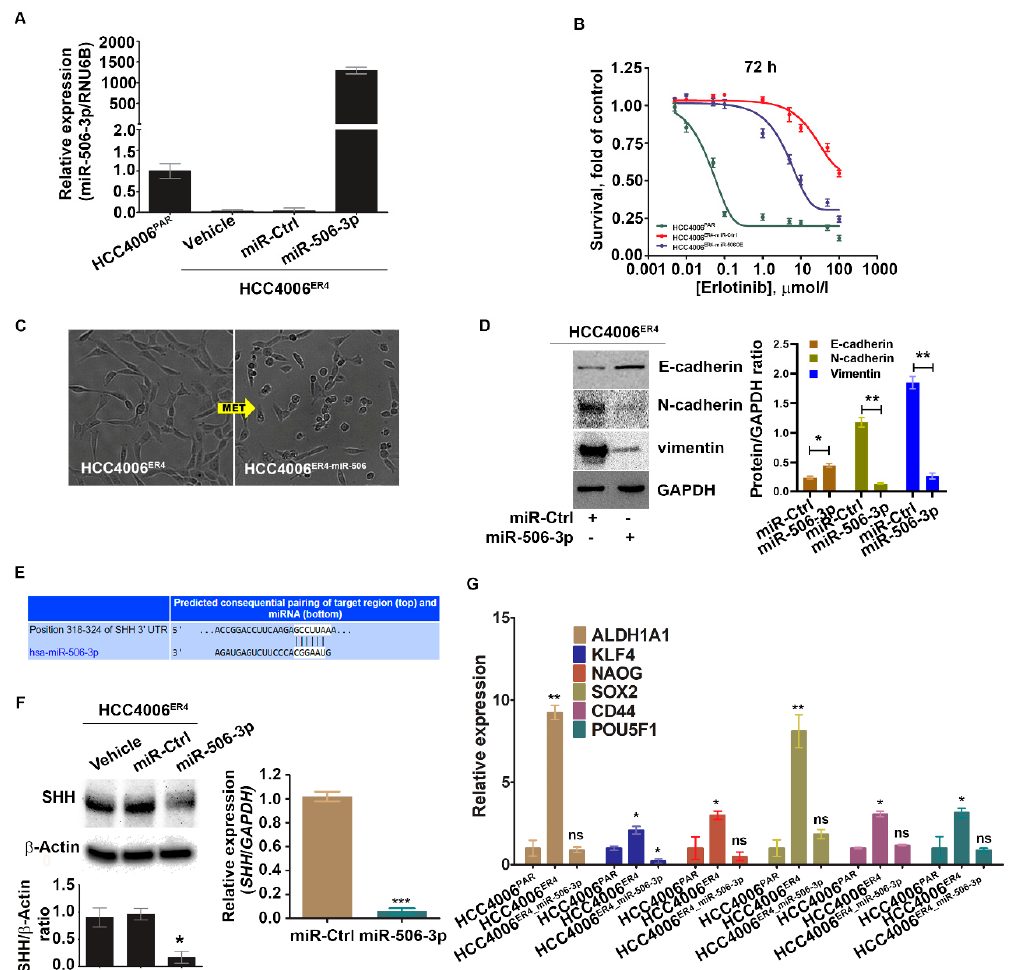
Figure 4. Ectopic expression of miR-506-3p increases erlotinib sensitivity by reversing EMT and downregulating SHH and other stem cell markers. ( A ) Real-time PCR analysis of miR-506-3p after transfection with miR-506-3p vectors into HCC4006 ER4 cells. The expression of miR-506-3p was normalized to the expression in HCC4006 PAR cells. Data are expressed as the mean ± SD, * p < 0.005, ** p < 0.0002 when compared to HCC4006 PAR . ( B ) The survival curves of HCC4006 PAR , miR-control erlotinib-resistant cells (HCC4006 ER4-miR-Ctrl ), and miR-506-3p overexpressed resistant cells (HCC4006 miR-506-3pOE )inthepresenceofdi ff erentconcentrationsoferlotinib. ( C )Thephotomicrographs represent the morphological changes (from mesenchymal-epithelial transition, MET) in HCC4006 ER4 and HCC4006 miR-506-3pOE cells (Magnification, 10 × ). ( D ) Western blot analyses of EMT markers in HCC4006 ER4 cells transfected with miR-Ctrl and miR-506-3p vectors. The right panel shows the SDi-quantitative estimation by densitometry analysis of protein bands. For semi-quantitative analysis, E-cadherins, N-cadherins, and vimentin bands are evaluated upon normalization with the corresponding housekeeping GAPDH protein band. * p < 0.005, ** p < 0.0035 when compared with HCC4006 ER4-miR-Ctrl cells. ( E ) Seed matched sequences for miR-506-3p in the coding region of SHH mRNA were identified by TargetScan 7.2. The sequences in white are the locations of the potential seed-matched sequences for the 3’UTR SHH and miR-506-3p. ( F ) Reduced expression of SHH in HCC4006 miR-506-3pOE cells compared to erlotinib-resistant cells (ER4-vehicle and ER4-miR-control). The bar graph shows the relative protein expression; β -actin was used as a loading control. Right panel indicates the quantitative relative expression of SHH mRNA in resistant cell lines transfected with miR-Ctrl and miR-506-3p vectors by real-time PCR. Data are presented as the mean ± SD for three independent experiments. Data are expressed as the mean ± SD * p < 0.001, *** p < 0.0001. ( G ) Real-time PCR analysis of stemness markers in HCC4006 PAR , HCC4006 ER4 , and HCC4006 miR-506-3pOE cells. ns, non-significant; * p < 0.01, ** p < 0.001 vs. HCC4006 PAR